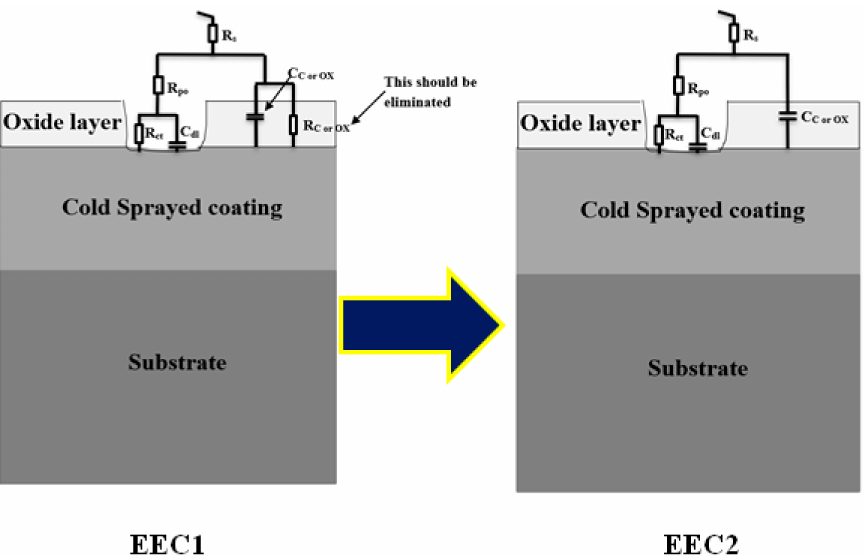
Figure 8. Schematic illustration of the developed EEC for fitting impedance spectra of CS Ti and CS Al-coated samples (per previous studies).